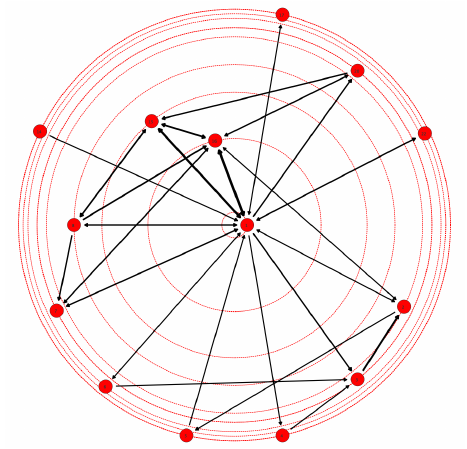
Figure 2. Social network for the Healthcare